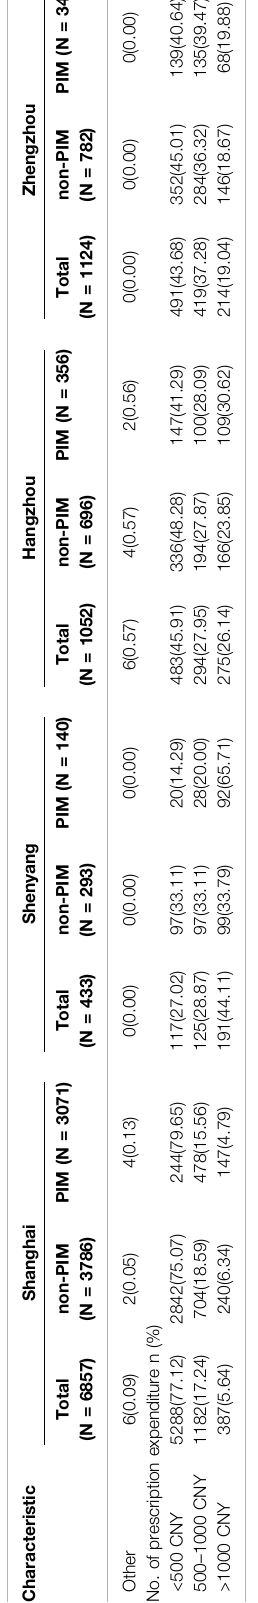
Figure 1 . According to the 2019 AGS Beers criteria, the antipsychotic drugs quetiapine and olanzapine were most frequently prescribed in older outpatients with PIM, accounting for 8.01% (1491) and 7.36% (1370), respectively. In addition, SSIRs (citalopram, sertraline) and sedative hypnotics (estazolam, zopiclone, alprazolam, zolpidem, lorazepam) were also observed in top drugs of PIM. Figure 2 lists the percentages and names of the top ten